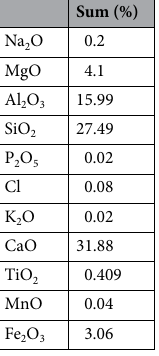
Table 1. Chemical composition of Melilite